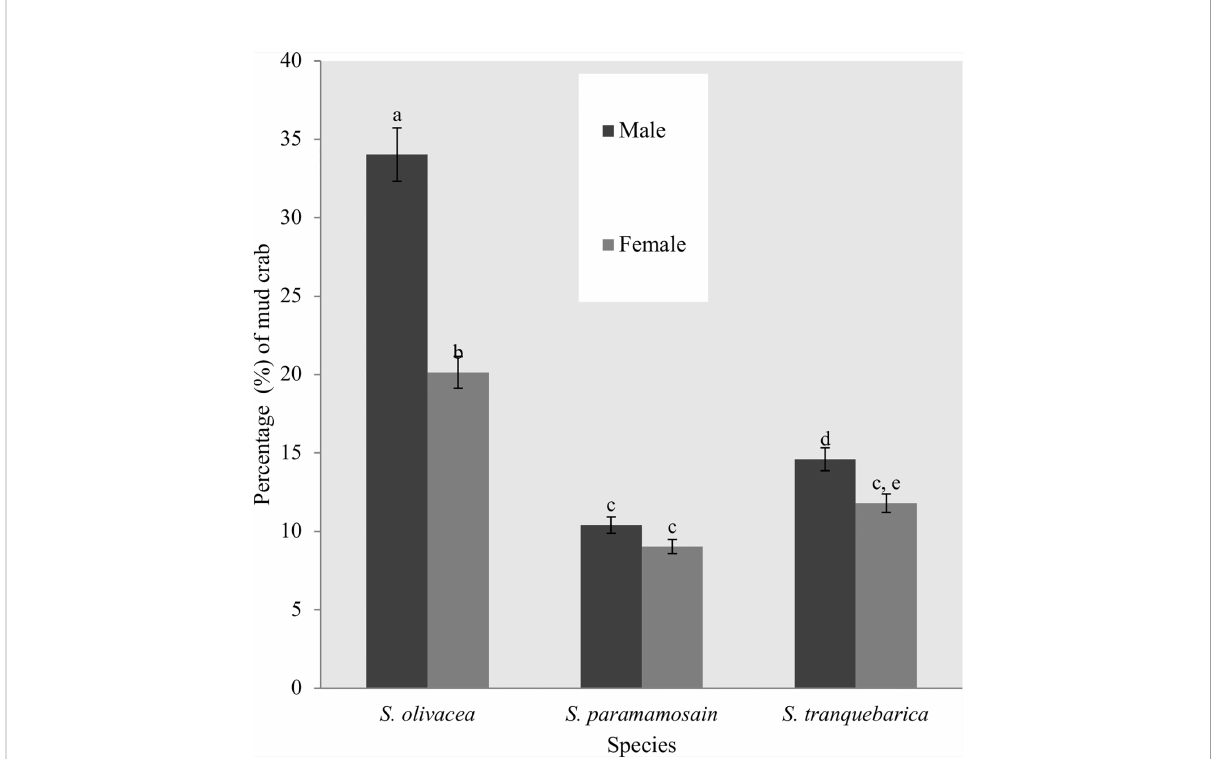
FIGURE 2 Percentage of mud crab species captured during the sampling trips of the study period at Setiu Wetlands. *Different alphabets between each bars showed the signi fi cant difference (p < 0.05) between